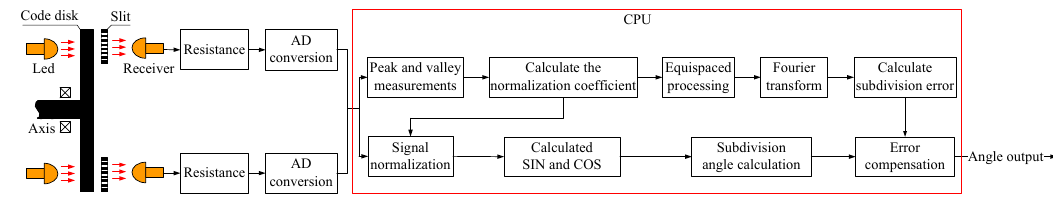
Figure 1. Schematic diagram of the encoder system.